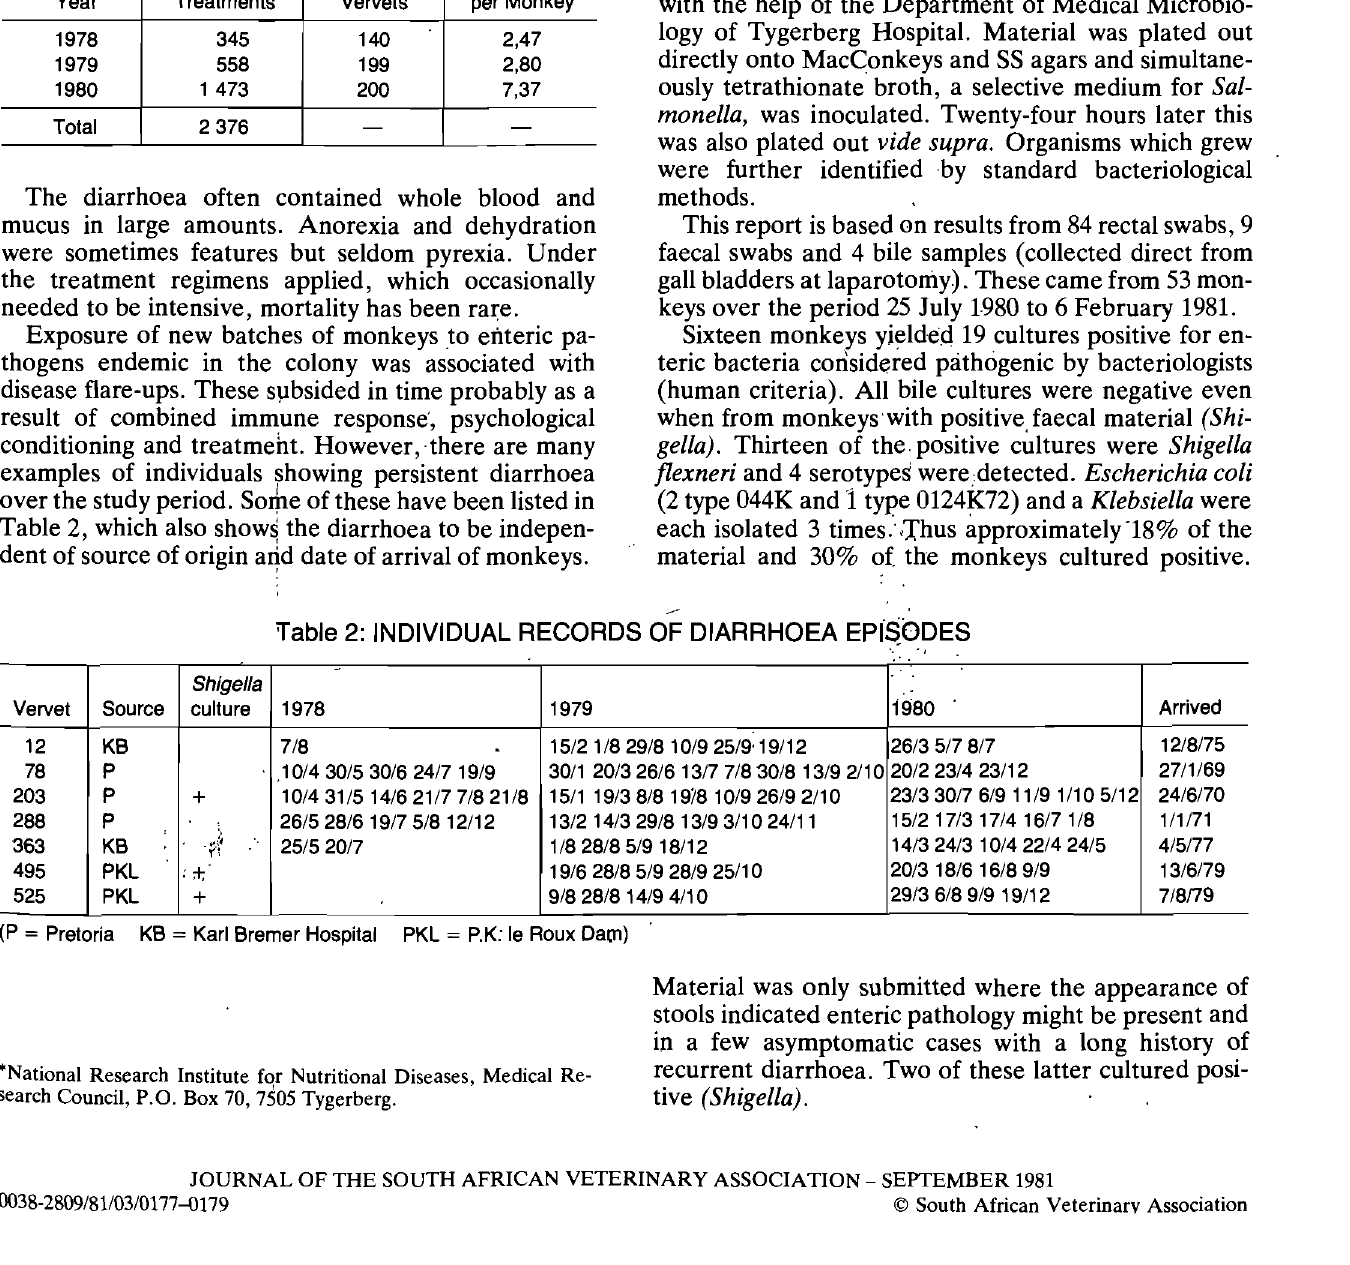
Table 1: ANNUAL DIARRHOEA TREATMENTS No. of Treatments